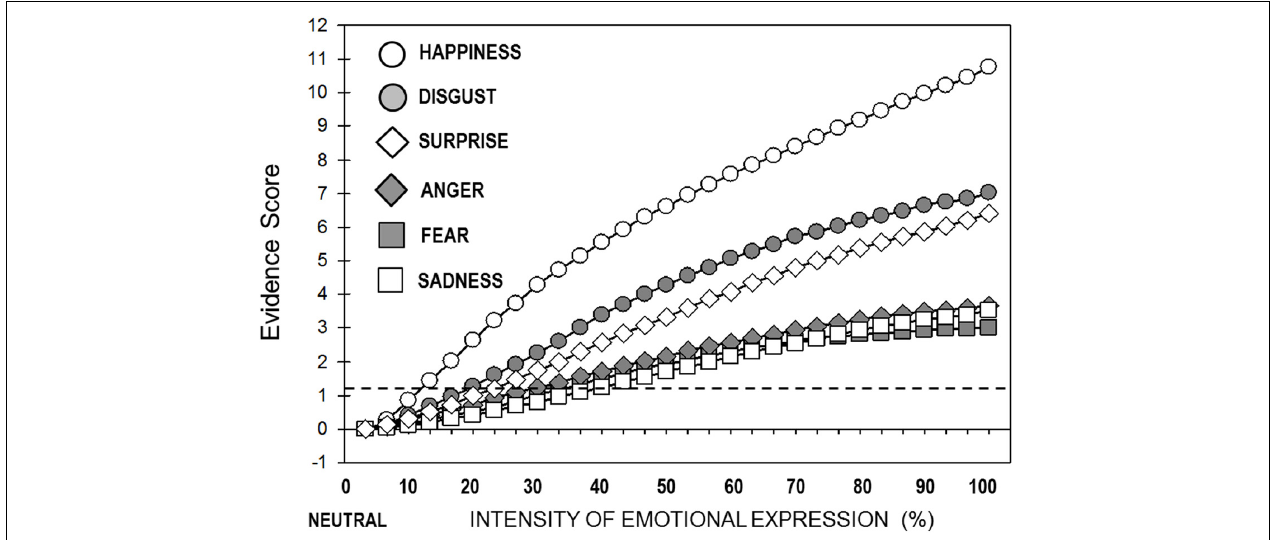
FIGURE 1 | Automated assessment of expressive intensity. Mean automated (FACET) difference (emotional minus neutral) evidence scores of each type of expression (response) across intensity levels for each expression stimulus. Above the dotted line: significantly different from the 0% (neutral) baseline (happy: 13.3% of intensity; disgust: 20.0%; surprise: 23.3%; anger and fear: 26.7%; sadness: 36.7%).